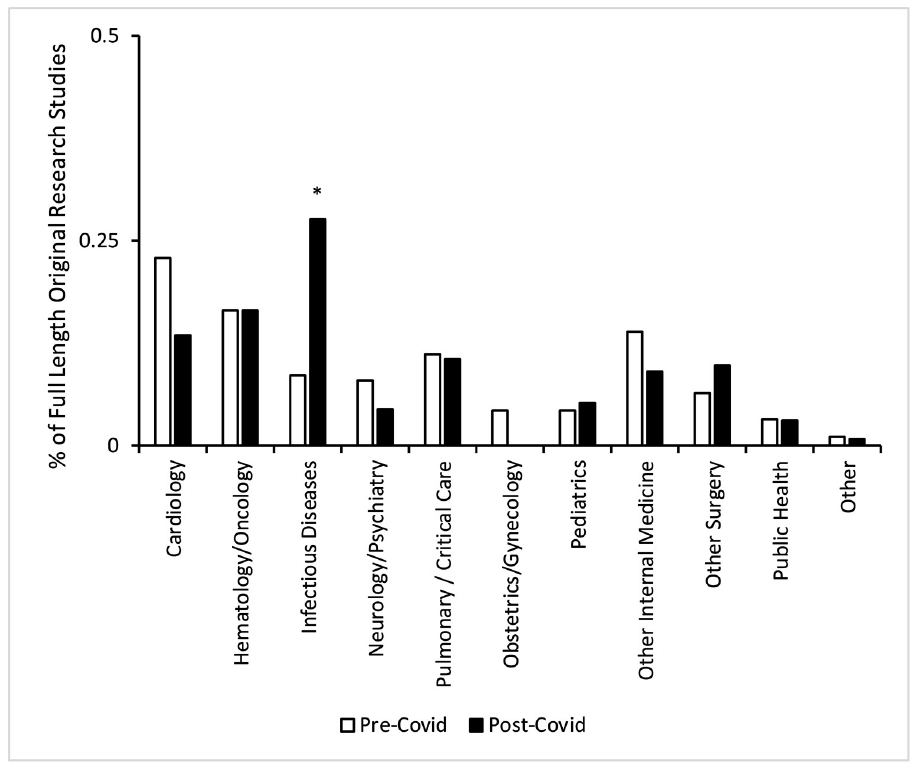
Fig 4. Distribution of full-length research studies pre- and post-Covid-19 by specialty. P-values were estimated using Fisher’s Exact Test. (an asterisk, � , denotes p < 0.0025). January 31, 2020 is the boundary between the pre- and post-Covid-19 eras.